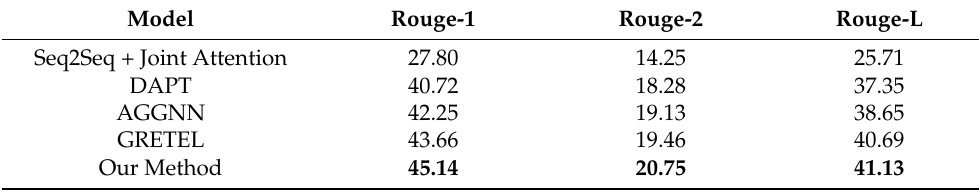
Table 2. Evaluation results of the baseline model on the CNN/Daily Mail dataset (%).